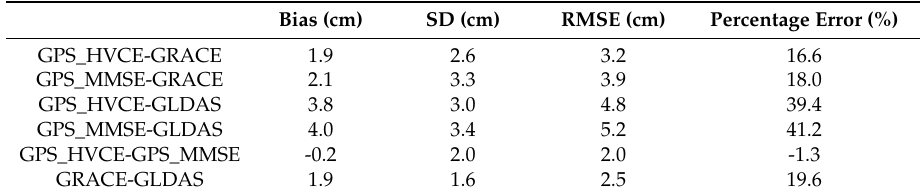
Table 3. Statistics of the differences between EWHs, and the Percentage Errors are calculated by Bias (a–b)/mean